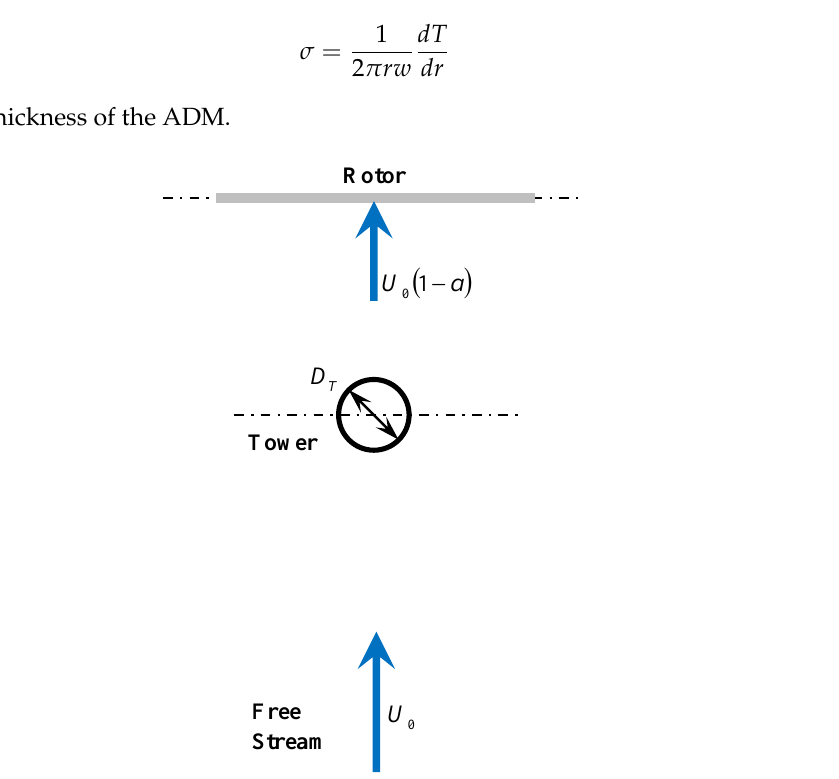
Figure 1. Top view of a downwind turbine. U 0 , free stream wind speed, D T , tower diameter.